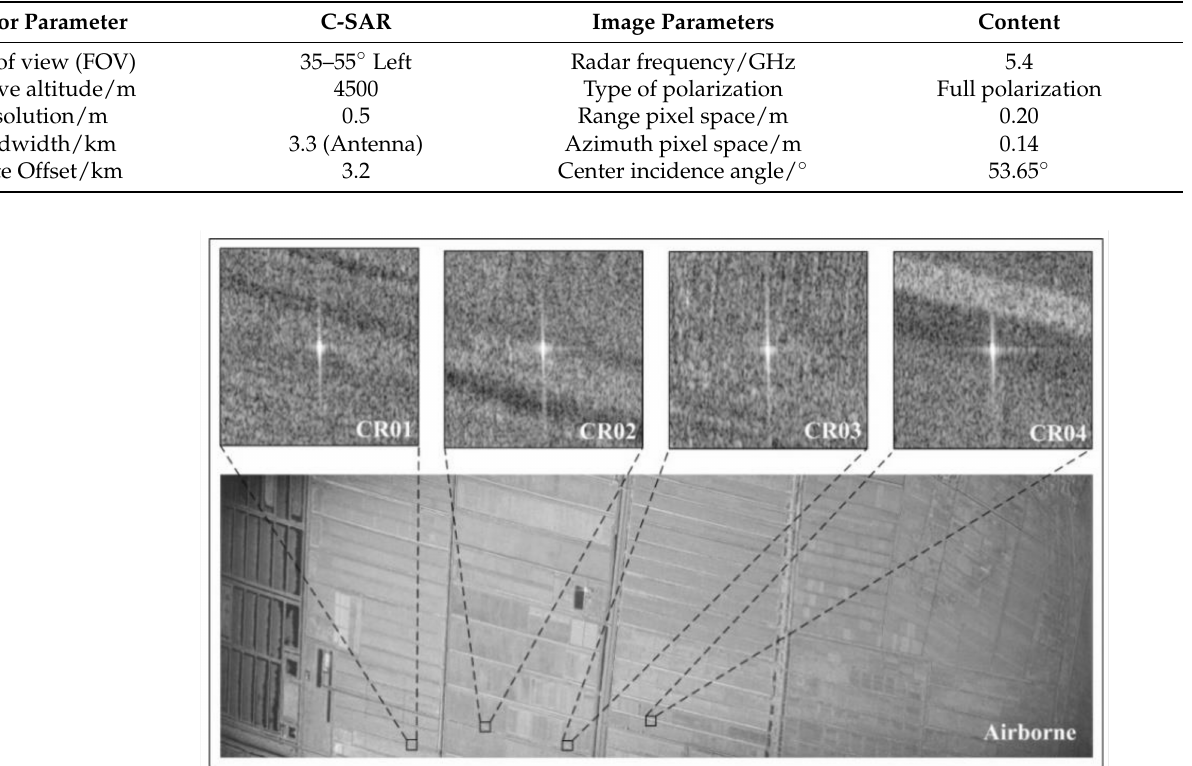
Figure 3. C-band VV polarimetric SAR image and the trihedral corner reflector